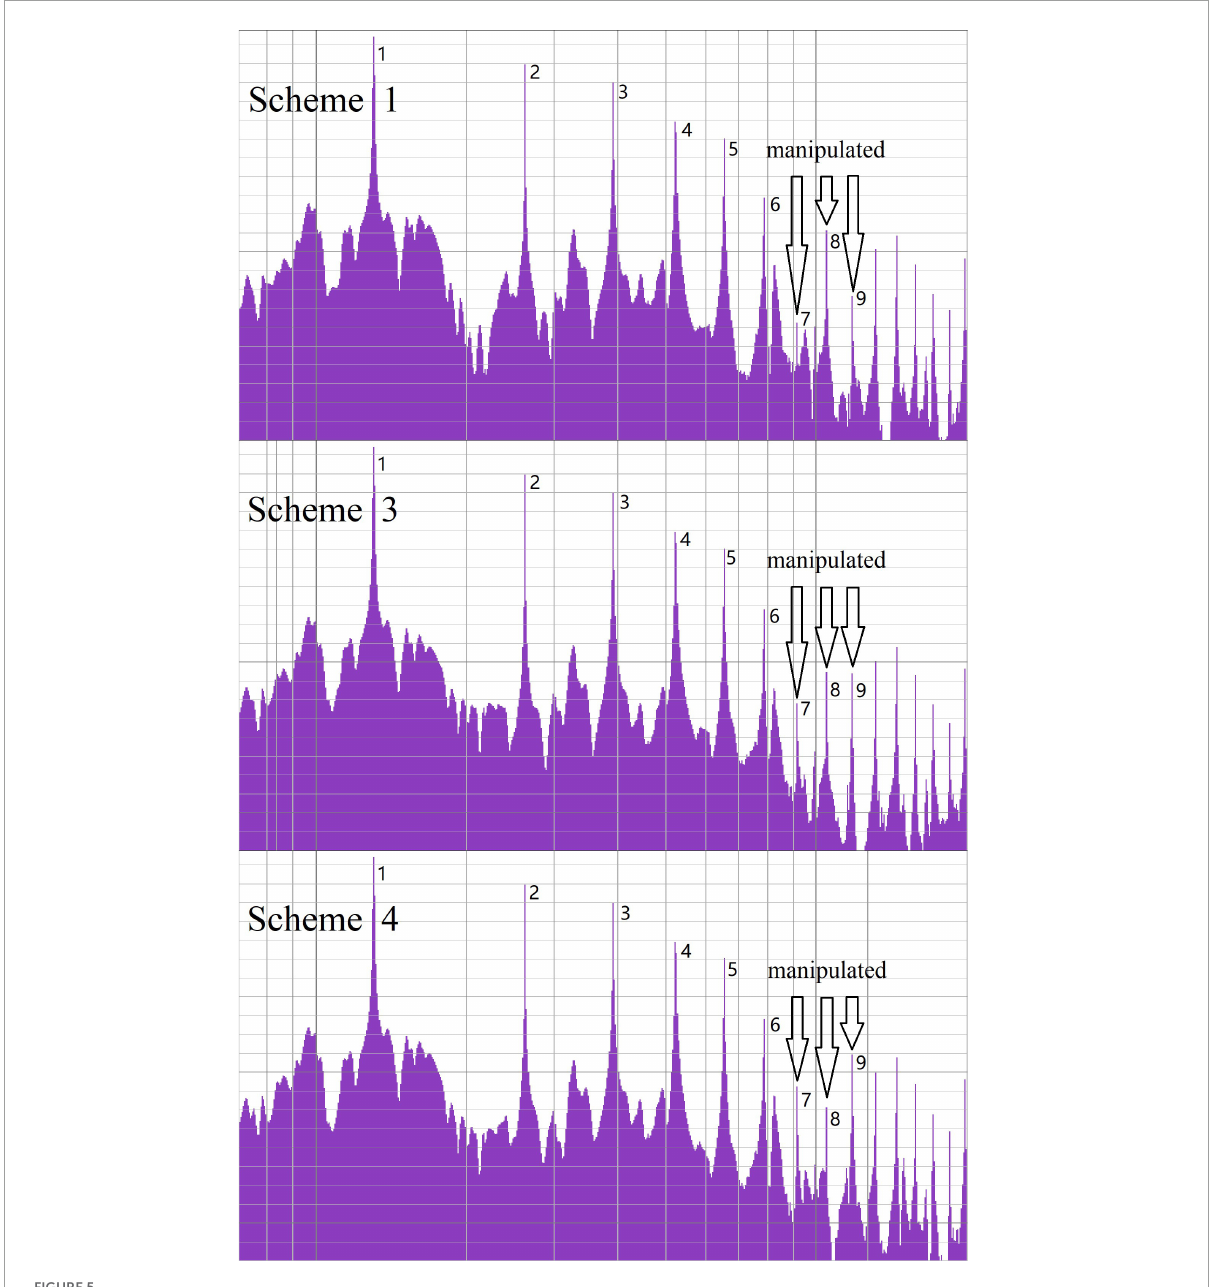
FIGURE5 Harmonic loudness in investigation